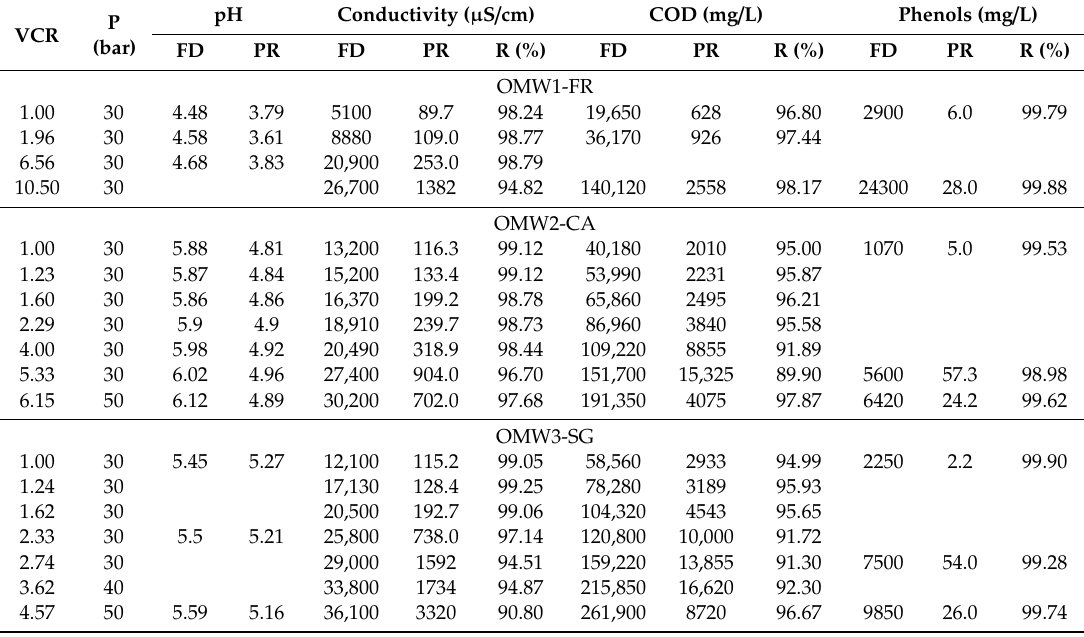
Figure 9. Permeate flux as a function of VCR during RO test with the MF permeate of OMW3-SG. Table 7. Main physicochemical properties of feed (FD) and permeate (PR) samples collected during RO test with the MF permeates of three di ff erent types of